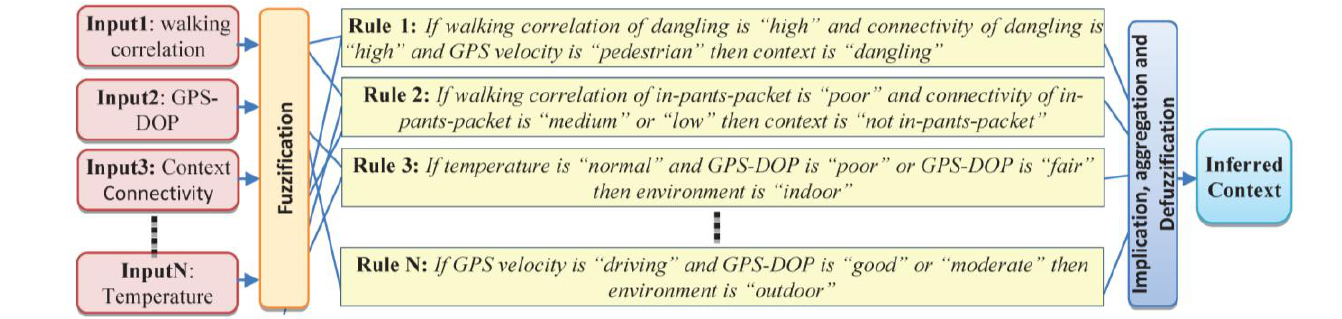
Figure 8. Evaluation of fuzzy rules using